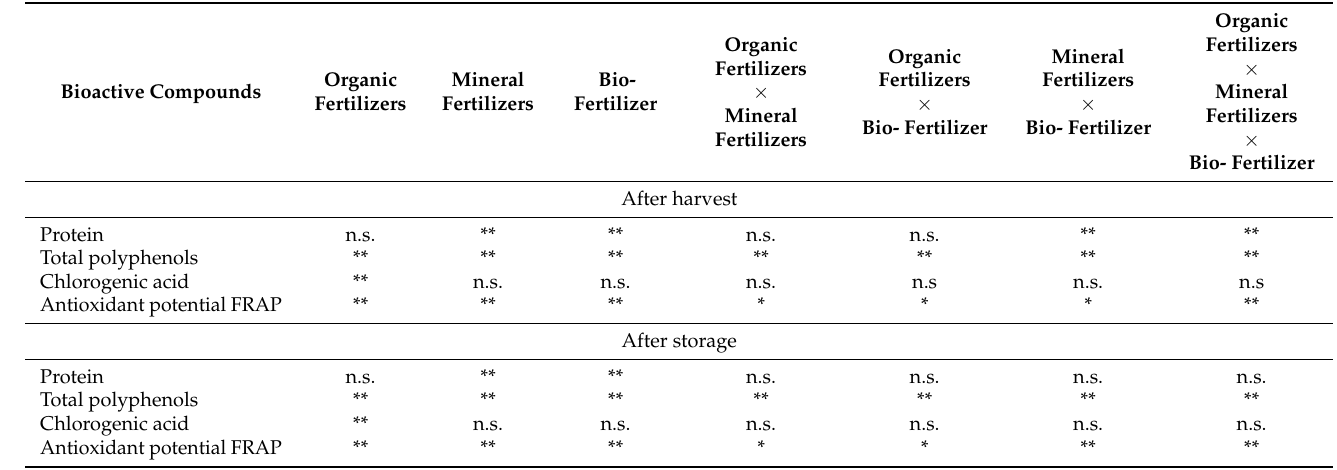
Table 1. Bioactive compounds after harvest and storage. Significance of experimental factors and their interaction, mean from the 3 years of study.